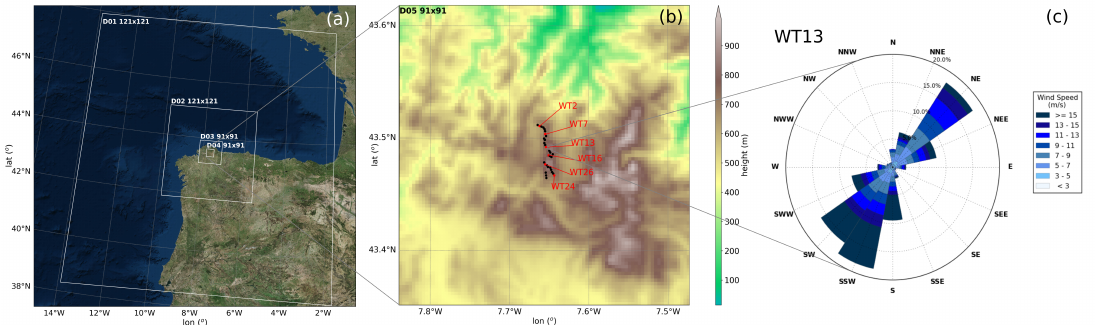
Figure 1. ( a ) WRF nested grid configuration, with the number of points for each domain indicated. ( b ) D04 is expanded showing its topography. Coruxeiras wind farm is located in the central area of D04, on top of a hill. Observational data for the study is obtained from meteorological stations at the hub of the wind turbines plotted in red. ( c ) Annual wind rose from observational data at hub height from a wind turbine in the center of the farm